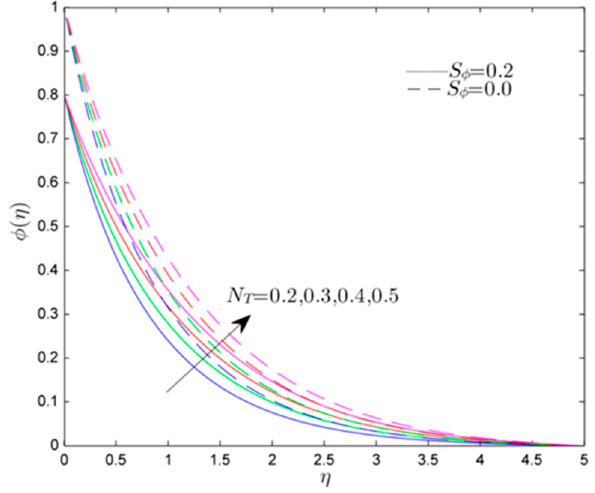
Figure 17. Effect of Thermophoresis parameter (𝑁 (cid:3021) ) on 𝜙(𝜂) .